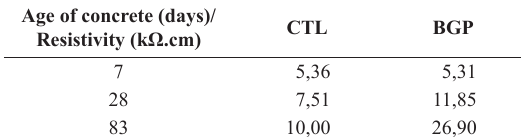
Table 4. Resistivity